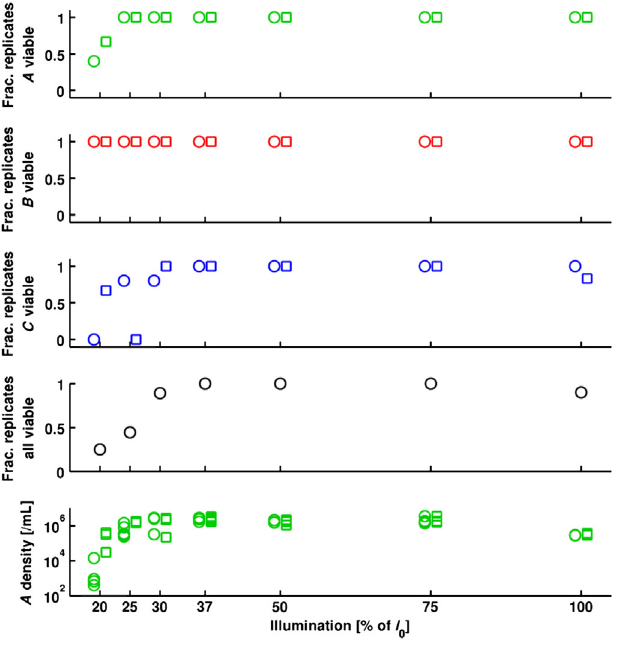
FIG. 7. Final viability and total algal density. Top four panels: Viability of each species, measured as described above, as a function of illumination. Green, red, and blue symbols show the fraction of systems with A , B , and C viable, respectively. Black squares show the fraction of replicates where all three species are viable. The two experiments in each illumination condition are represented by circle and square symbols. Bottom panel: Density of C. reinhardtii , as measured by flow cytometry, from a well- mixed sample of each replicate, at the end of each experiment as a function of illumination condition. A single point is plotted for each replicate with symbols denoting different experiments within each illumination